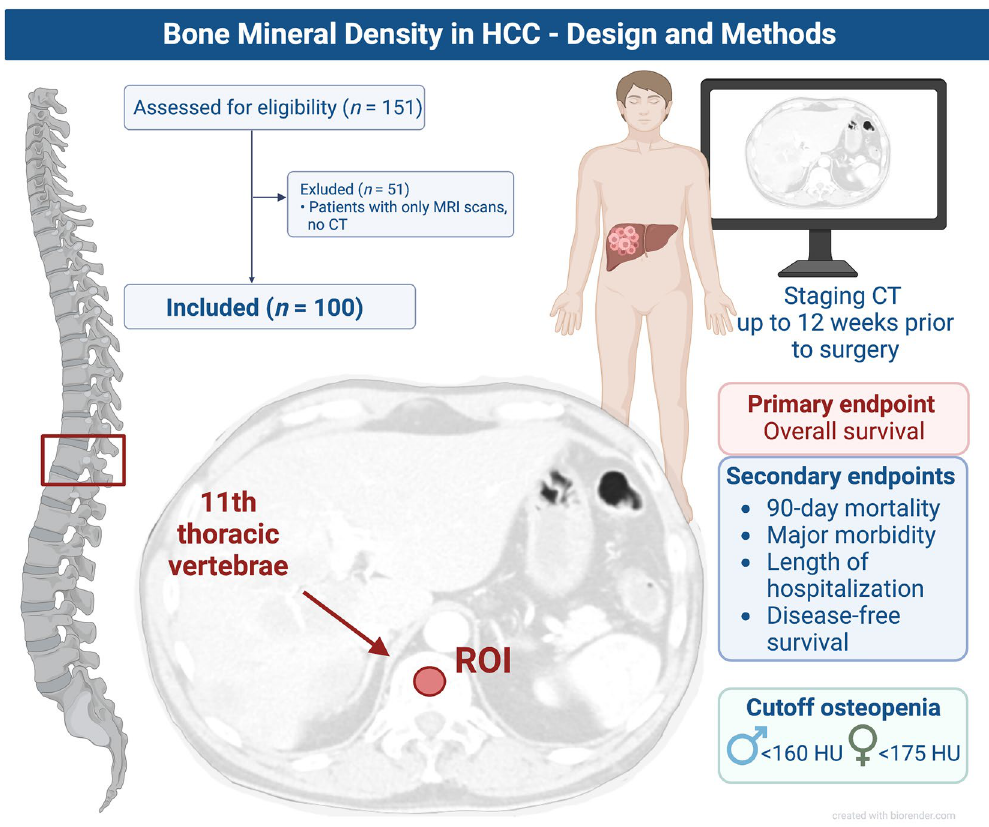
Figure 1. Abbreviations used: HCC: hepatocellular carcinoma; CT-computed tomography; ROI: region of interest; HU: Hounsfield units. This figure was created using